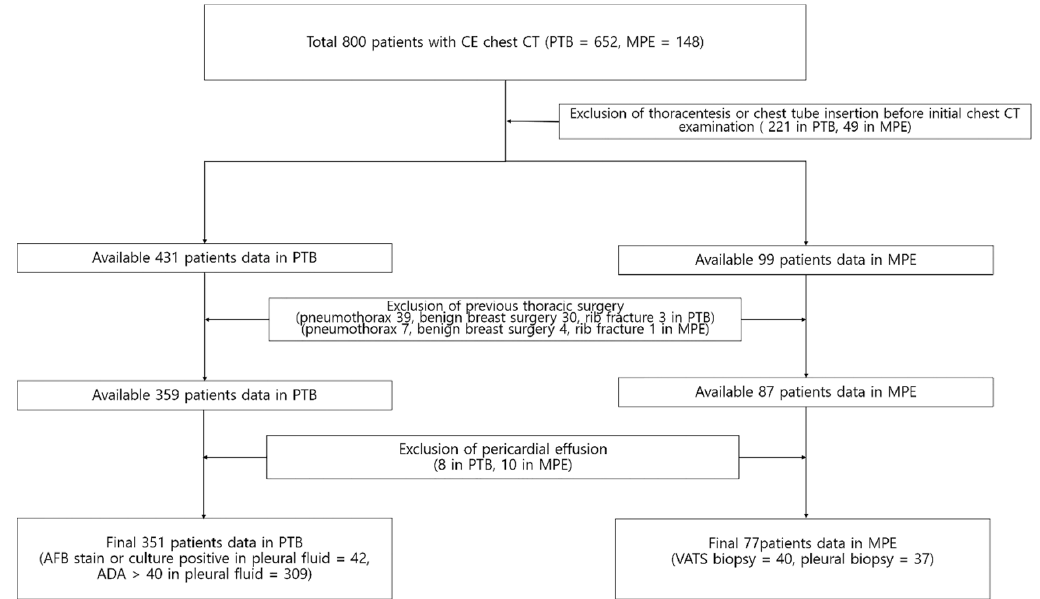
Figure 1. Flow chart showing the selection of the study cohort.